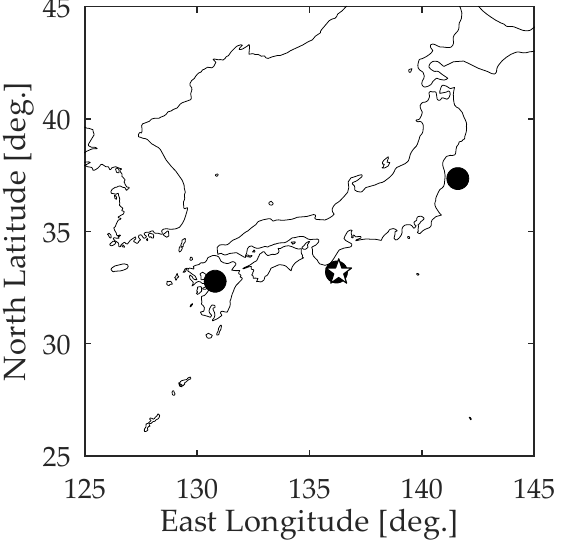
Figure 2. Location of the epicenters and the KMDB1 station of DONET observatory. The epicenters are shown as filled circle, and the KMDB1 station is shown as a pentagram.